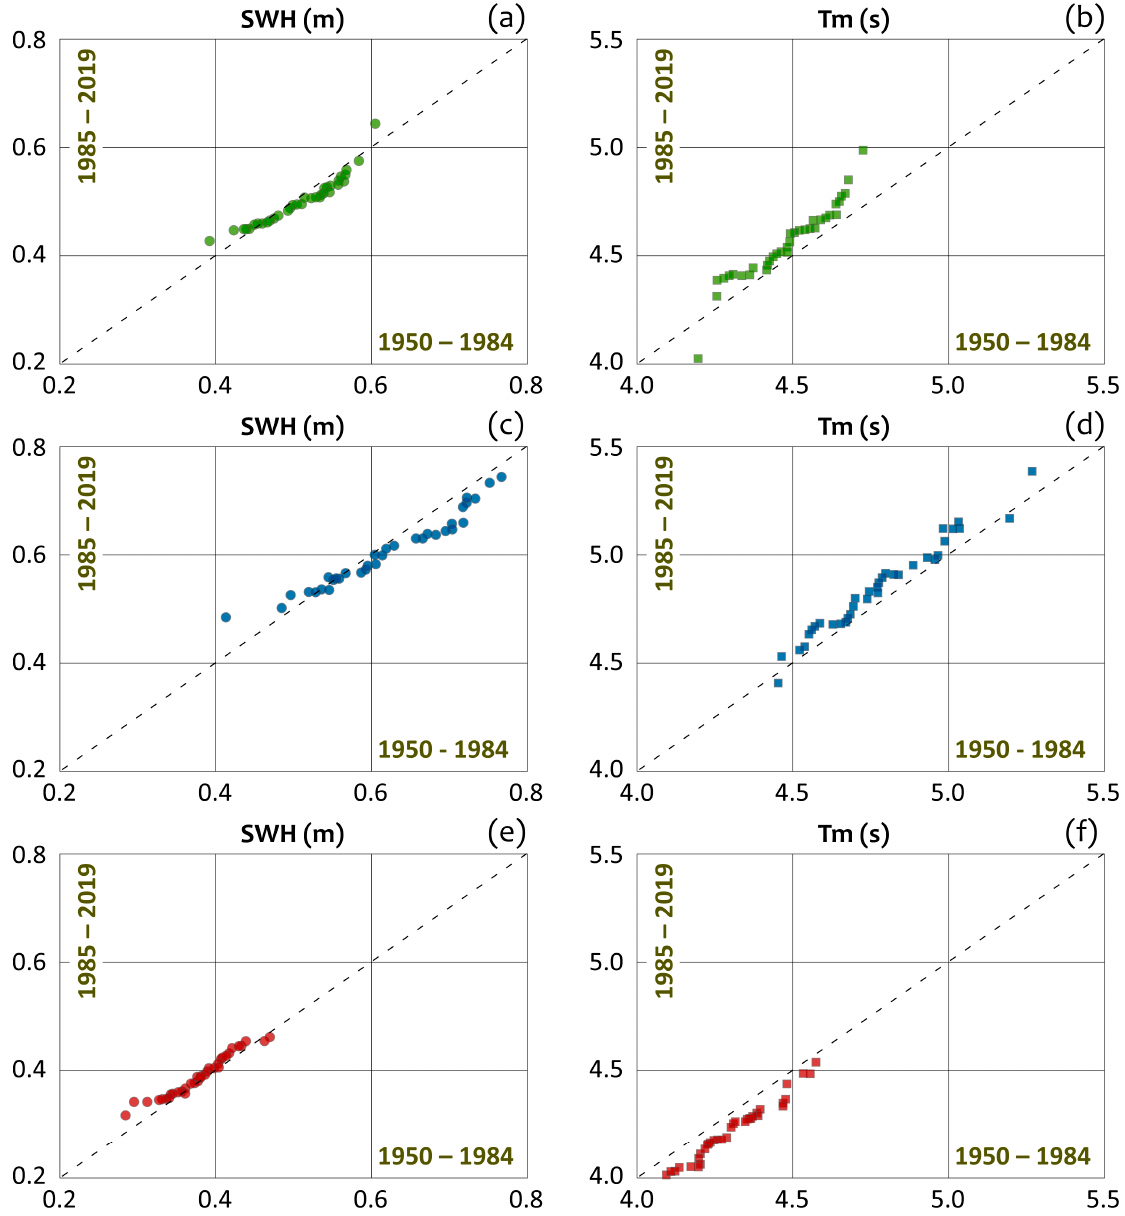
Figure 10. ERA5 reanalysis dataset 1950–2019. The ITA method for SHW (left side) and Tm (right side). The annual mean (green, ( a , b )), cold season (blue, ( c , d )), and hot season (red, ( e , f